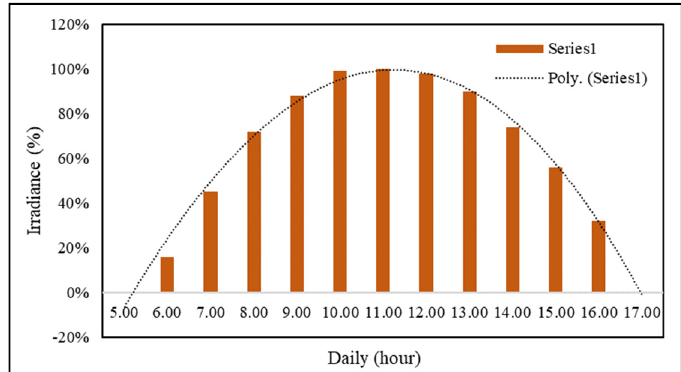
Figure 11. Daily solar irradiance in Karimunjawa.